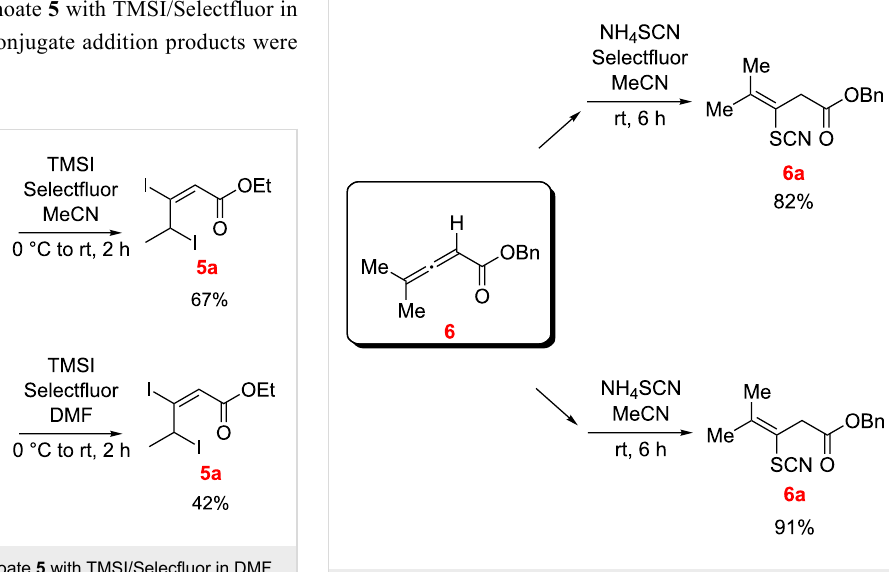
Scheme 8: Reaction of ethyl allenoate 5 with TMSI/Selecfluor in DMF and MeCN as the solvents ( E/Z designations, as illustrated, were made by NMR; see Supporting Information File